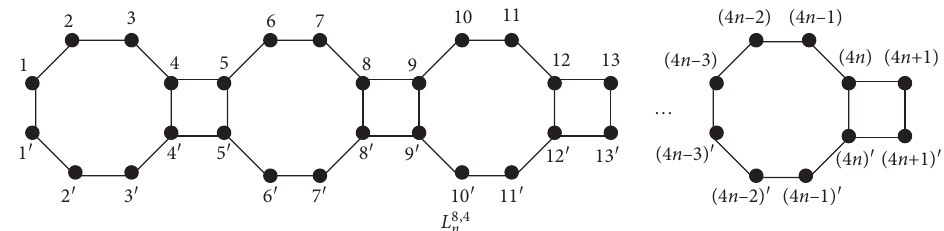
Figure 1: Linear octagonal-quadrilateral